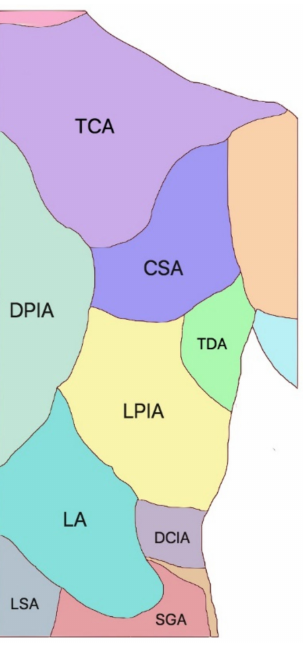
Figure 3. Right half posterior trunk and vascular territories. TCA, transverse cervical artery; DPIA, dorsal branch of the posterior intercostal artery; CSA, circumflex scapular artery; TDA, thoracodor‑ sal artery; LPIA, lateral branch of the posterior intercostal artery; LA, lumbar artery; DCIA, deep circumflex iliac artery; SGA, superior gluteal artery; LSA, lumbosacral artery.